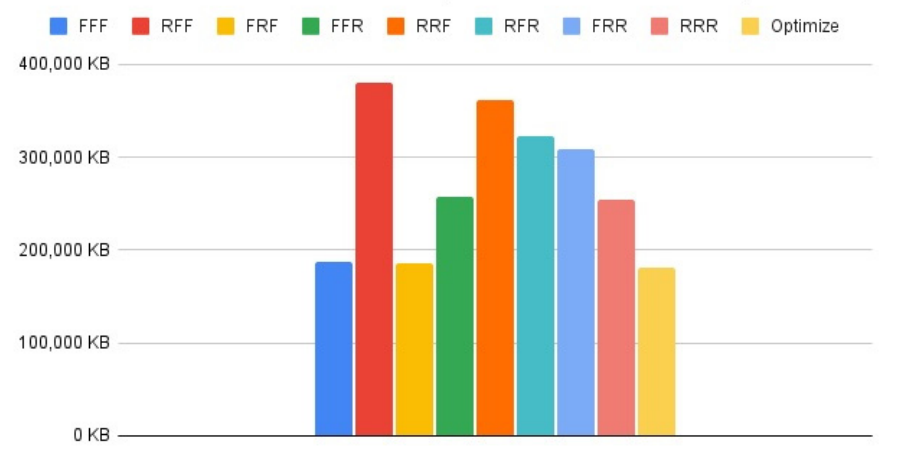
Figure 14. Total DRAM access—HarDNet39 (1024 PE/128 KB Buffer).